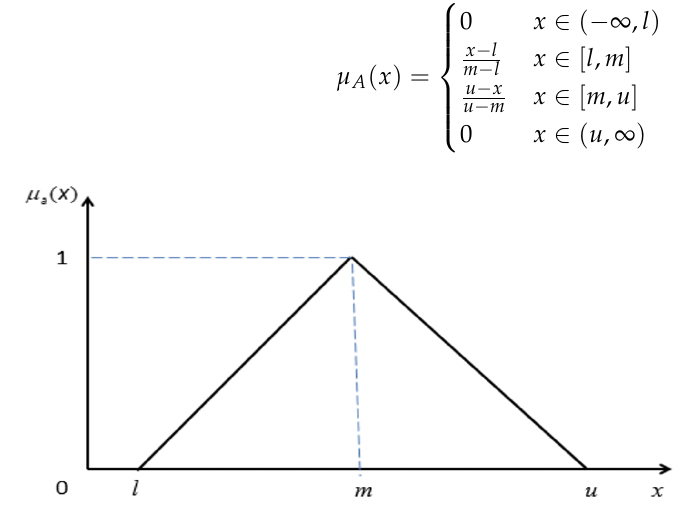
Figure 2. Triangular fuzzy